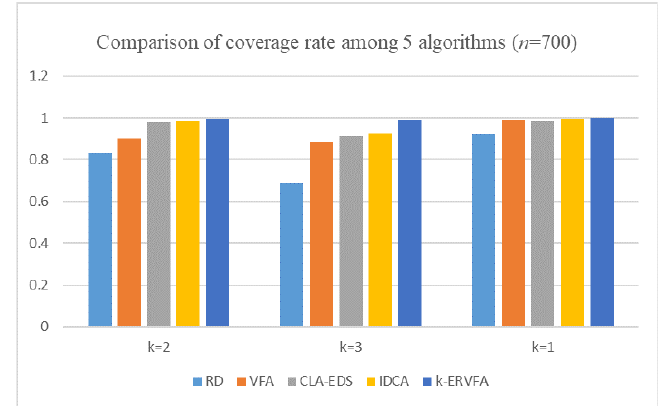
Figure 6. Comparison of the coverage rate among the five algorithms ( n =